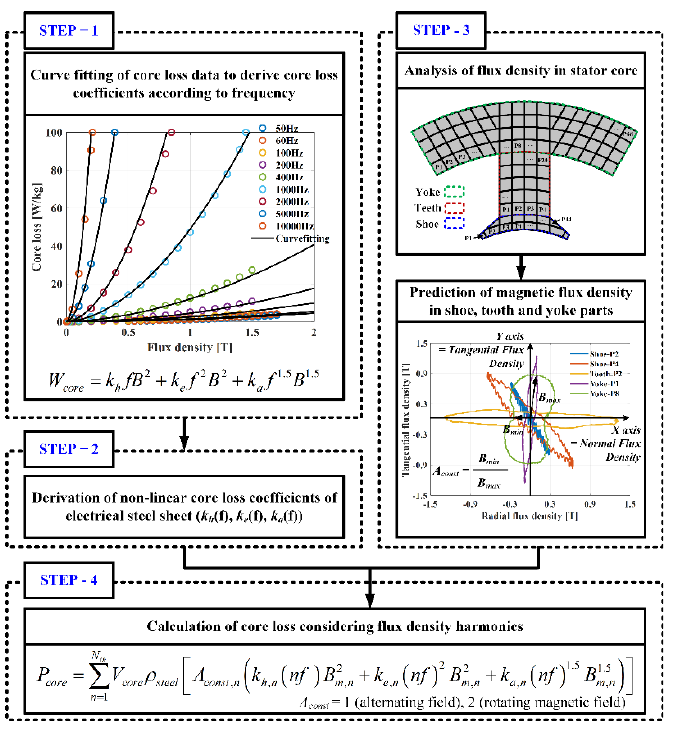
Figure 9. Calculation process of core losses considering magnetic field behavior and